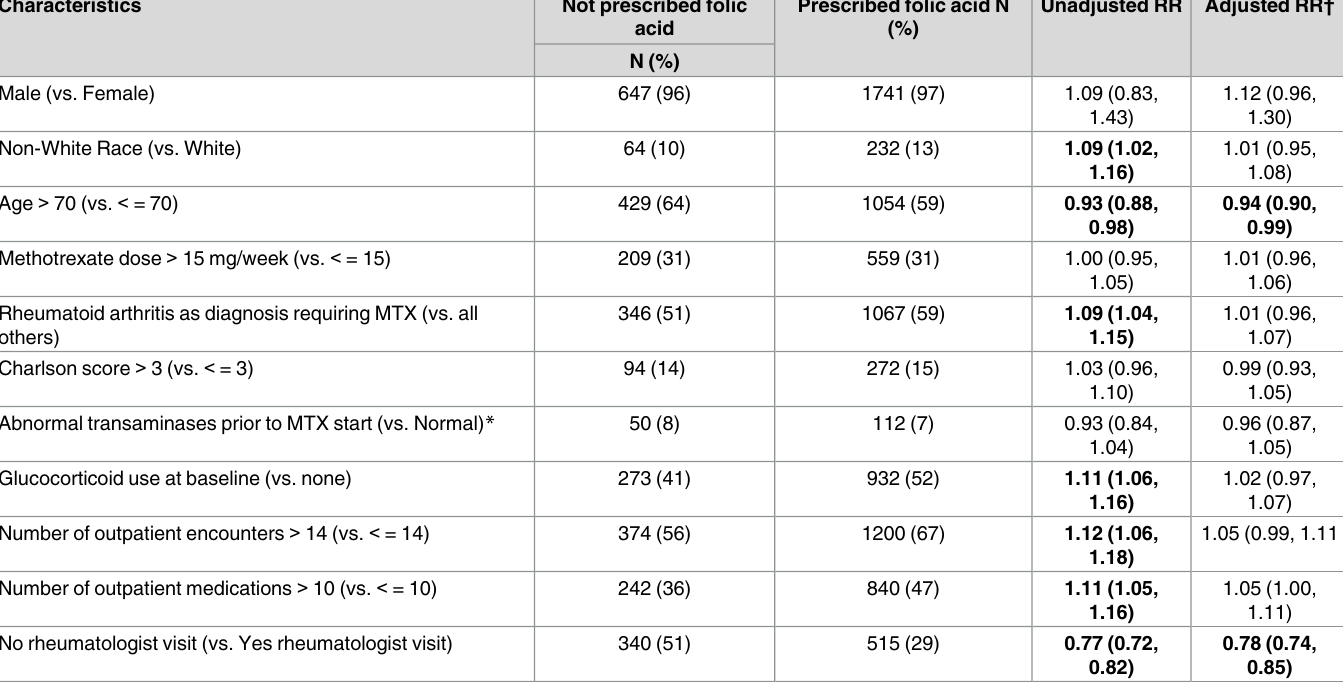
Table 2. Factors associated with folic acid receipt, and multivariate model predicting folic acid receipt within 30 days of first methotrexate prescription.